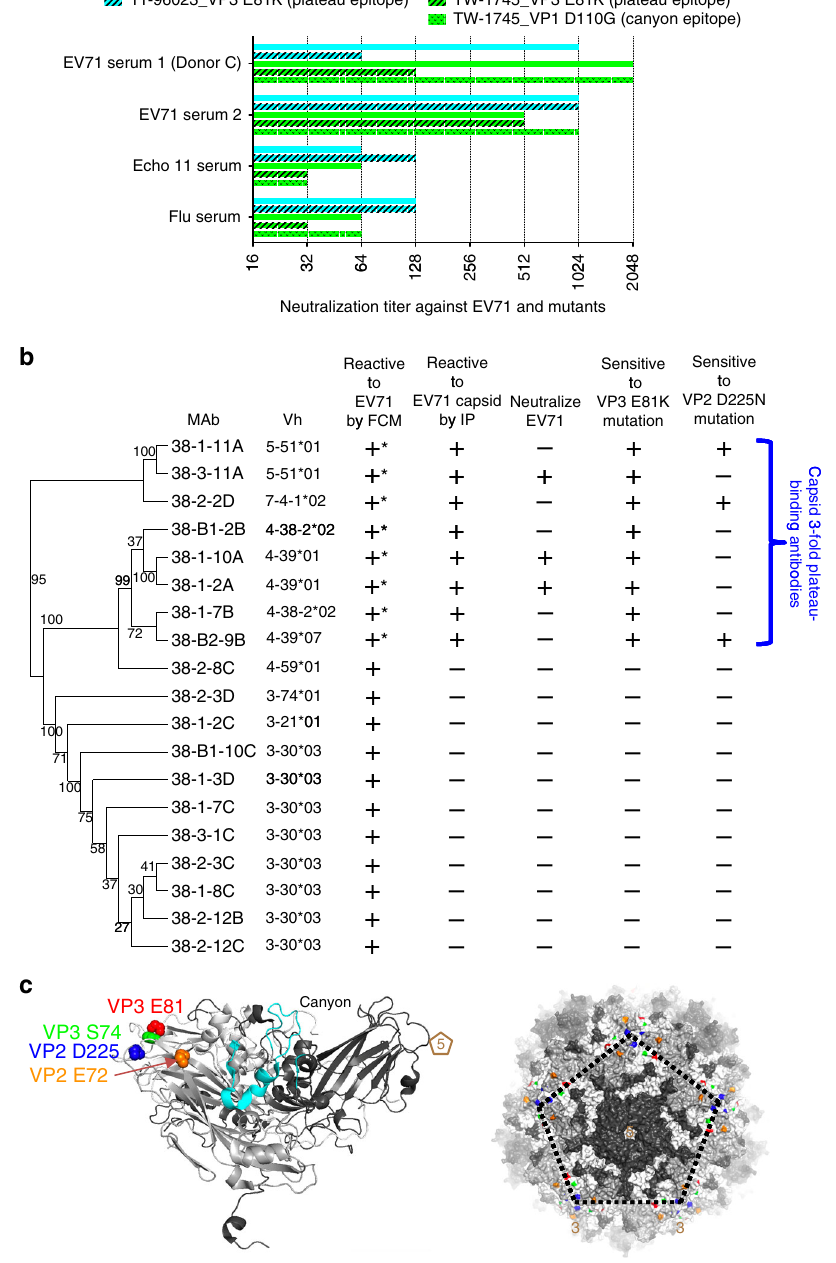
Fig. 1 Breadth and speci fi city of EV71-speci fi c antibody response in donor C. a Serological response against wild-type EV71 and its epitope variants. The virus (11-96023_VP3 E81K) was an escape variant selected with neutralizing antibody in vitro 13 and the TW-1745_VP3 E81K and TW-1745_VP1 D110G were generated in vitro by introducing the residue substitution into an infectious cDNA clone of EV71 (strain TW-1745, GenBank accession number KT354870.1) via site-directed mutagenesis 13 . Donor C developed a strong antibody response at day 9 after illness onset which focused on the threefold plateau epitope of EV71 capsid. A post-EV71 infection serum (day 10 of illness onset) from another paediatric donor, a post-echovirus 11 infection serum (day 10 of illness onset) and a post-in fl uenza virus infection serum (day 11 of illness onset) were included in the experiment. The neutralization assay was carried out twice with equivalent results. Source data are provided as a Source Data fi le. b Characterization of 19 plasmablast-derived EV71-speci fi c monoclonal from donor C, measured by the fl ow cytometry (FCM), ELISA, immunoprecipitation (IP) and neutralization assays. Those marked by stars bound to puri fi ed native viruses in the direct ELISA. Eight of 19 EV71-speci fi c antibodies reacted to conformational epitopes on the viral capsid. A distance tree (cladogram) was constructed by neighbour-joining methods (1000 bootstrap replications) using heavy chain variable domain sequences of 19 EV71- speci fi c human monoclonal antibodies (SeaView software). Bootstrap support values are shown for major nodes on the tree. c Mapping of threefold plateau epitope (VP3 E81 coloured in red, VP3 S74 coloured in green, VP2 D225 coloured in blue and VP2 E72 coloured in orange) based on the EV71 capsid structures 4CEY. The side view of a cartoon diagram of EV71 icosahedral asymmetric unit and the surface view of a pentamer are shown with the fi vefold vertex at the centre and created using the software program PyMOL. The capsid VP1 protein is coloured in black, VP2 coloured in grey and VP3 coloured in white. The contact region for hSCARB2 cellular receptor 12 is coloured in